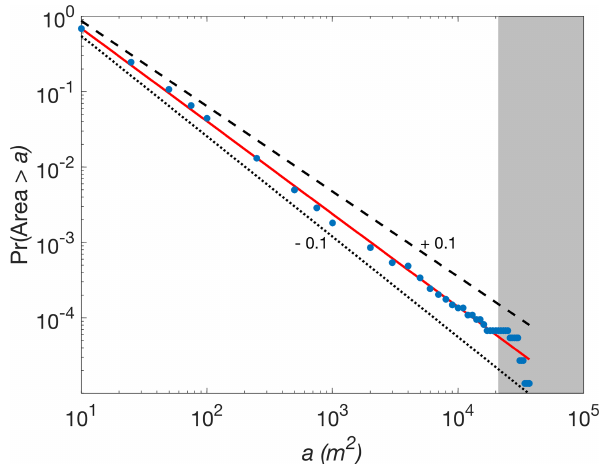
Figure 3. Power-law fit for the iceberg areas in the proximal zone on 10b June. The red line represents the best fit, and the black lines show the mismatch resulting from shifting the power exponent by ± 0 . 1 (the dotted line indicates a subtraction of 0.1, and the dashed line indicates an addition of 0.1). The largest icebergs that have been omitted to achieve a statistically significant fit are plotted in the gray